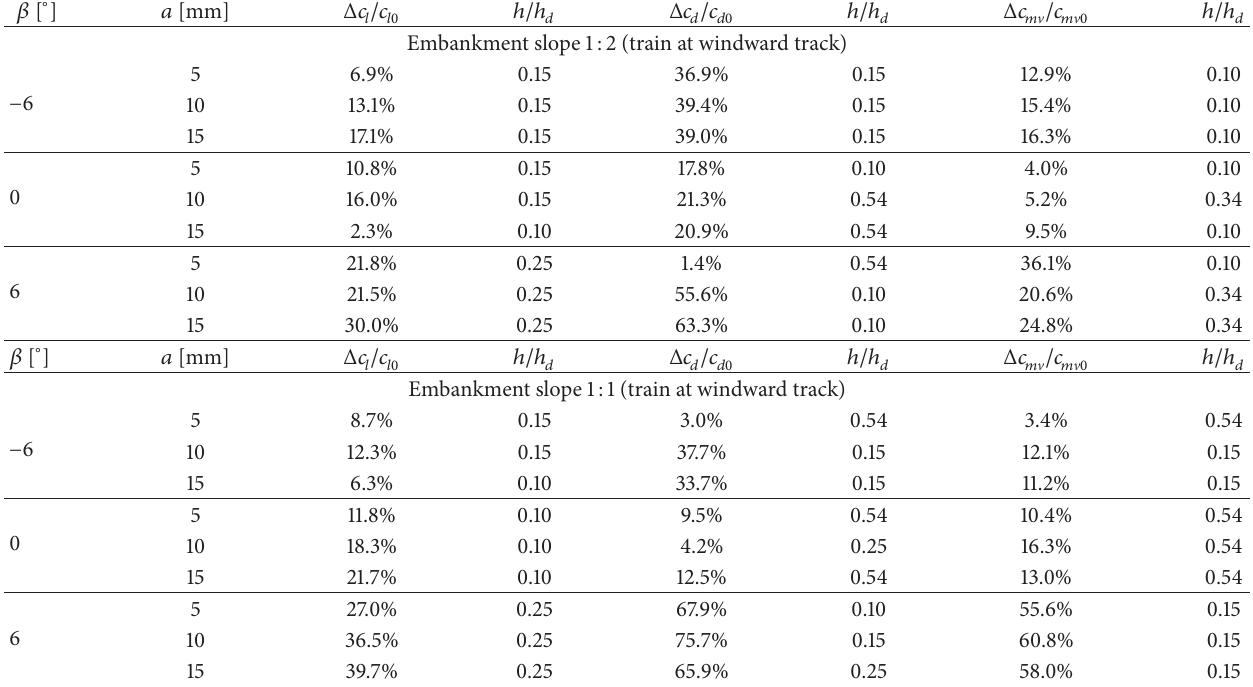
Table 3: Highest percentage reduction on the aerodynamic loads on the train at windward track with eave-parapets, in relation to the aerodynamic loads measured with no-eave-parapets ( 𝑎 = 0 ). The height of the parapet where the highest reduction is obtained is also included in each